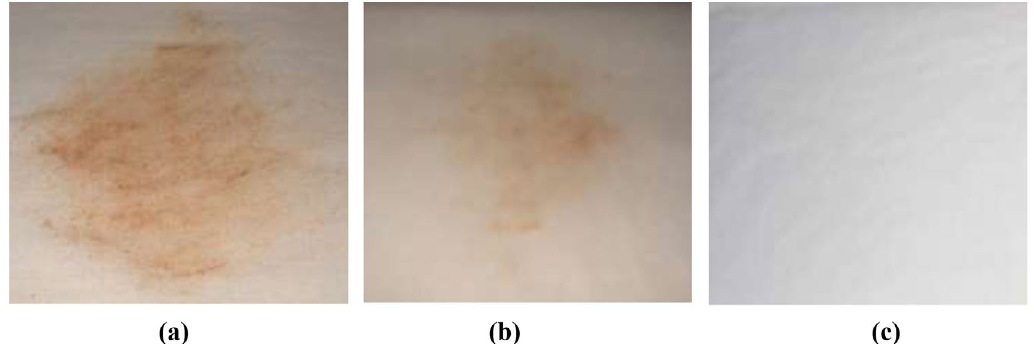
Fig. 6. (a) Images of chocolate ice cream spot on cotton cloth. (b) Images of chocolate ice cream spot taken after washing in TX-100 with detergent additives without mannanase and after additional particulate soil treatment. (c) Images of chocolate ice cream spot taken after washing in TX-100 with detergent additives with mannanase and after additional particulate soil treatment.